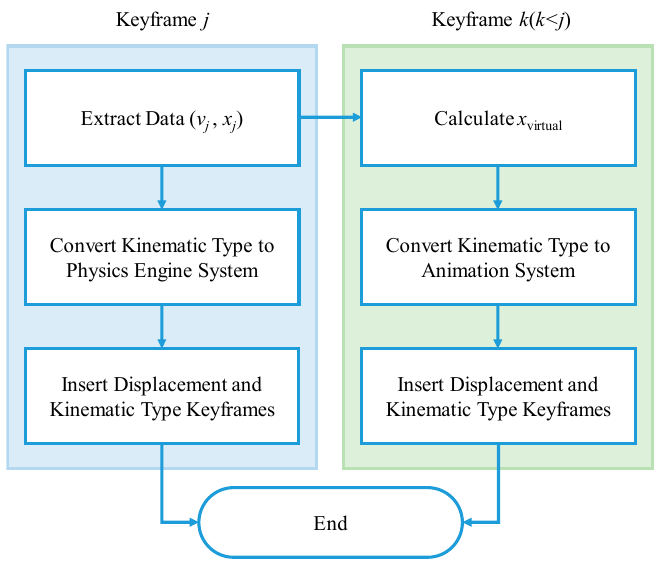
Figure 6. Flowchart of the velocity mapping method.